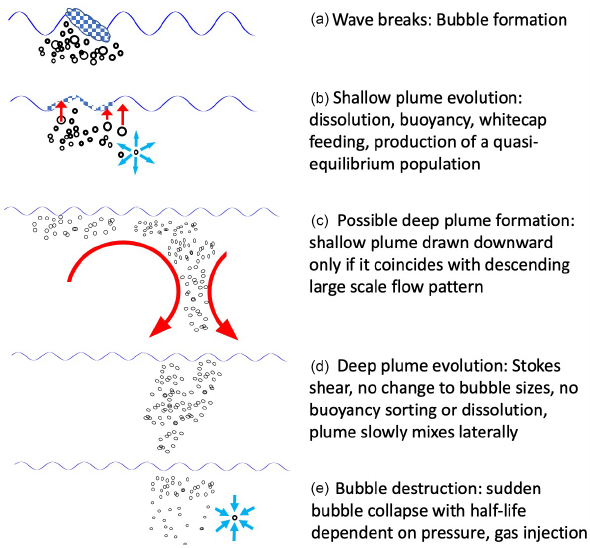
Figure 11. Schematic setting out the major stages of bubble forma- tion, evolution and destruction, as described in the